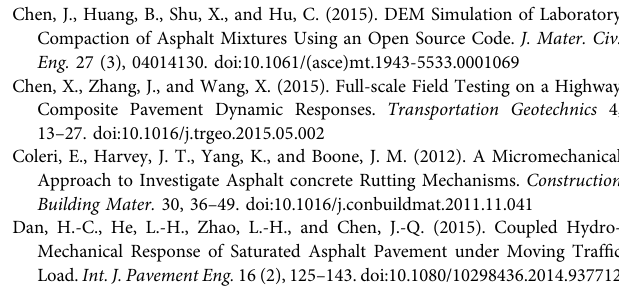
Frontiers in Materials |